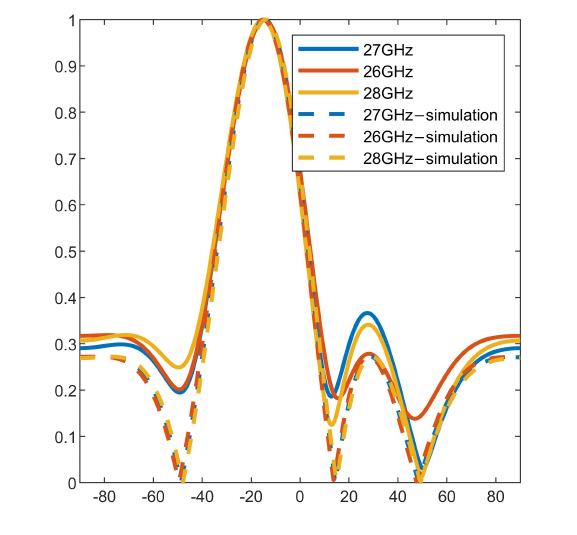
Figure 8. Beam squint with non-true time delay.